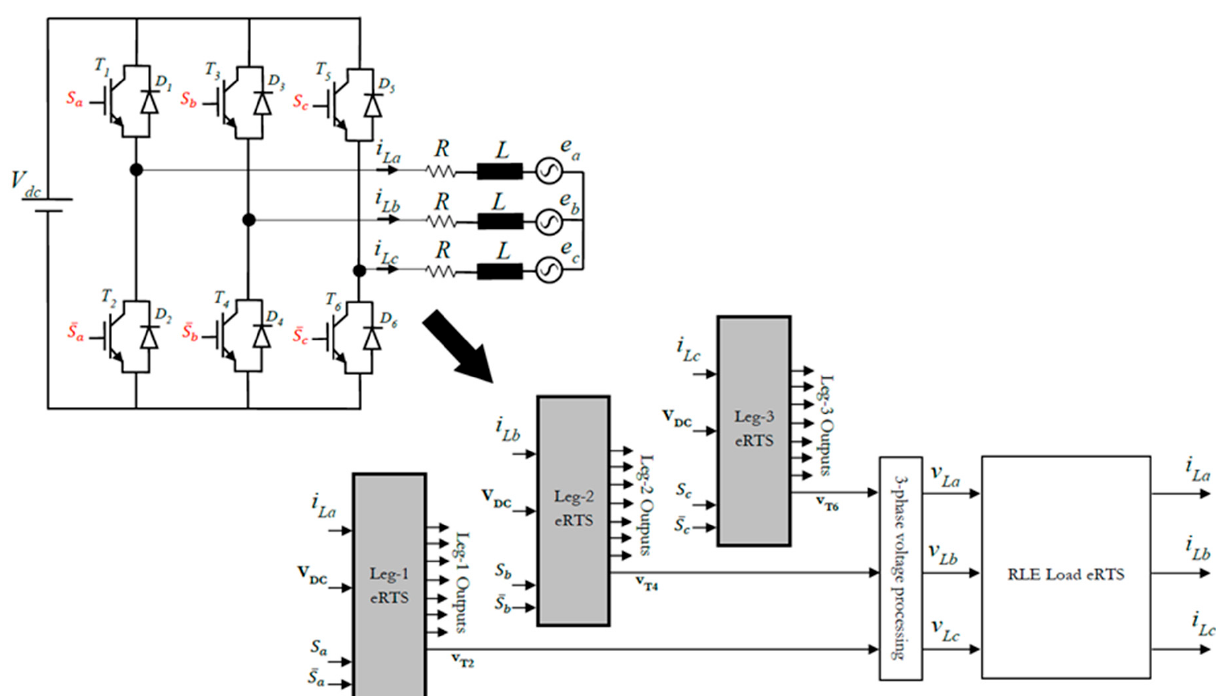
Figure 5. eRTS architecture of a three-phase VSI supplying an RLE load.